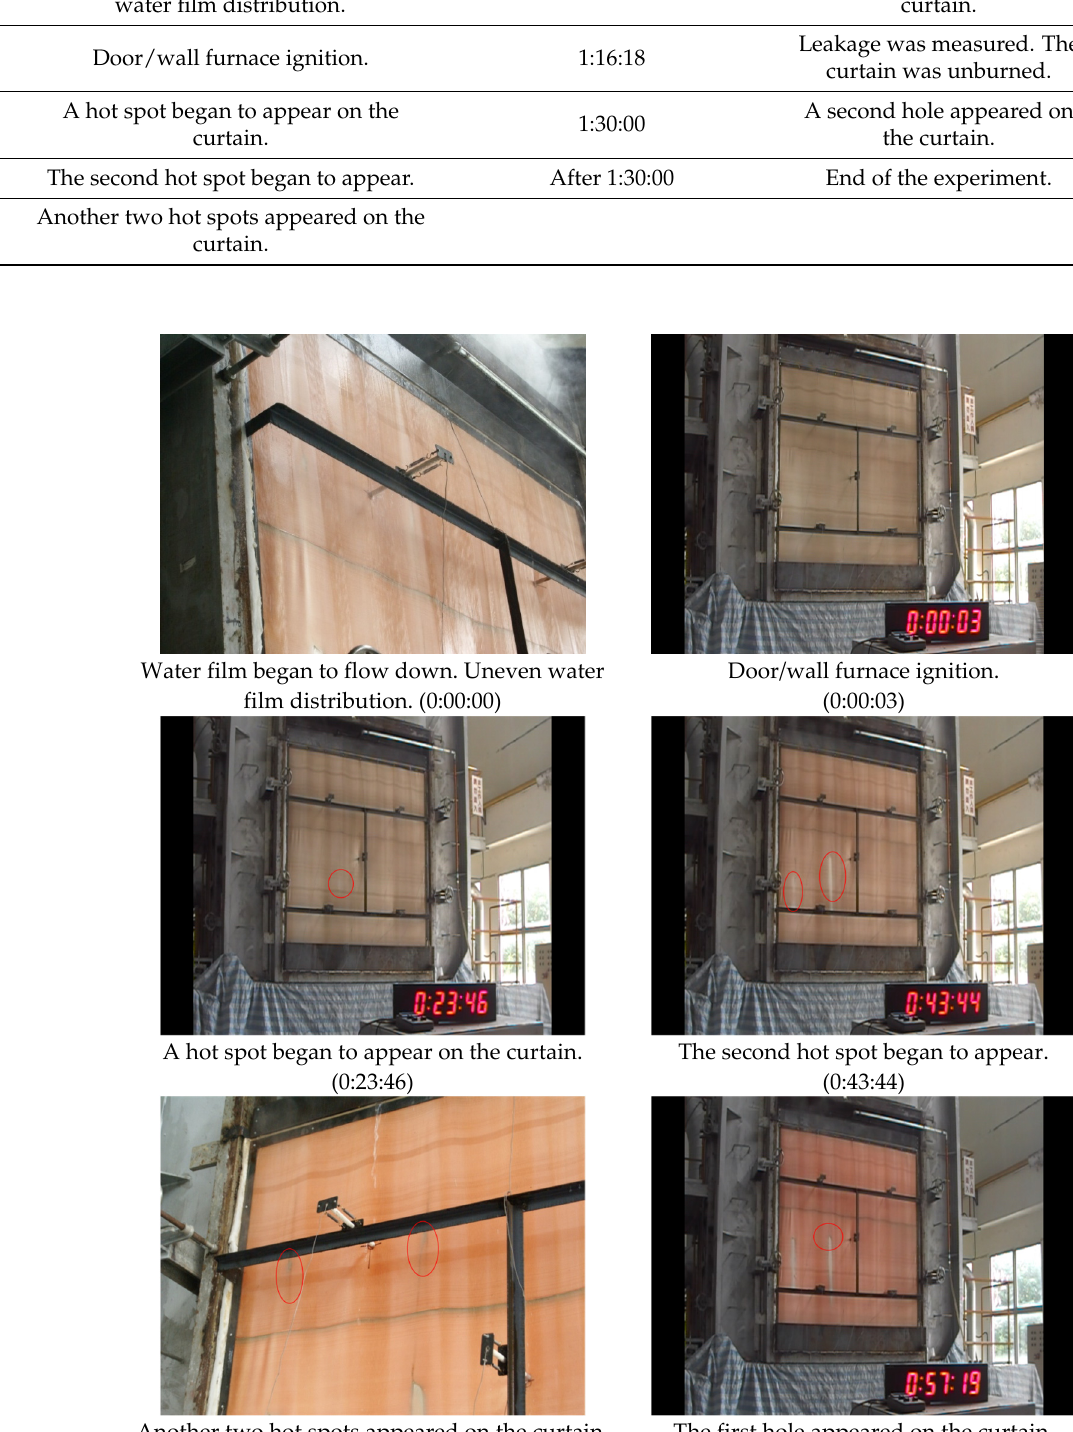
The first hole appeared on the curtain.